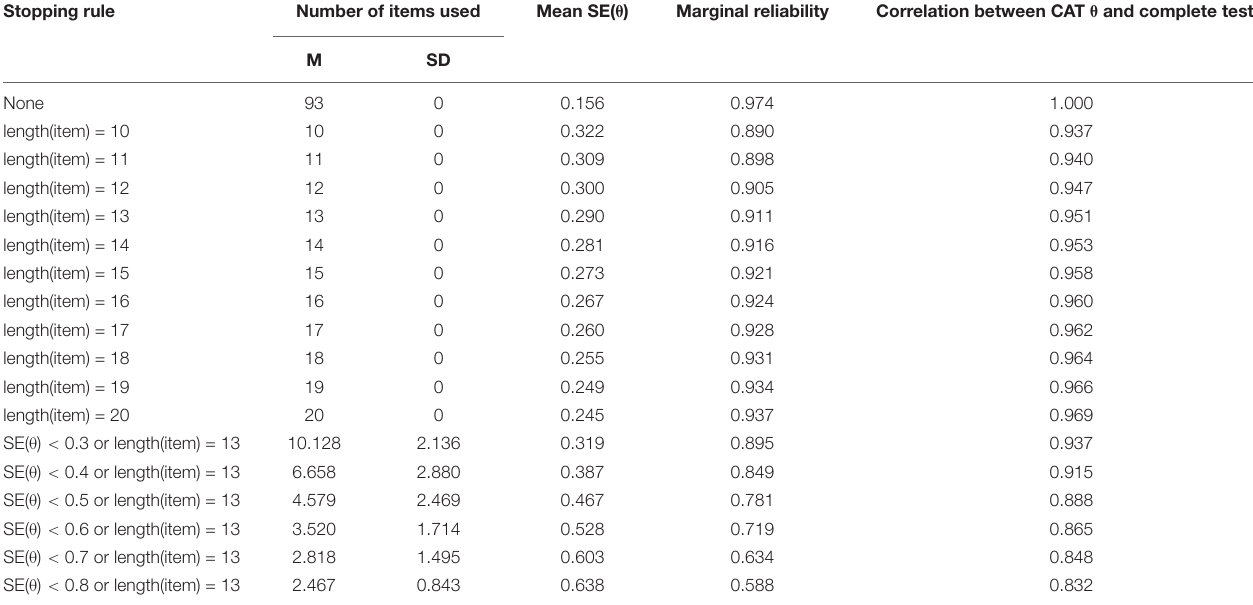
TABLE 3 | Characteristics of the CAT under different stopping rules.